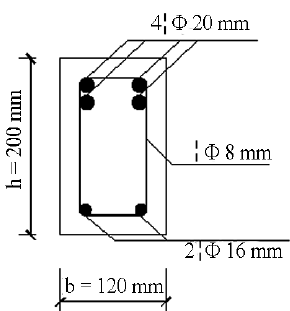
Fig. 4. Cross sectional dimensions of reinforced concrete cantilever pile